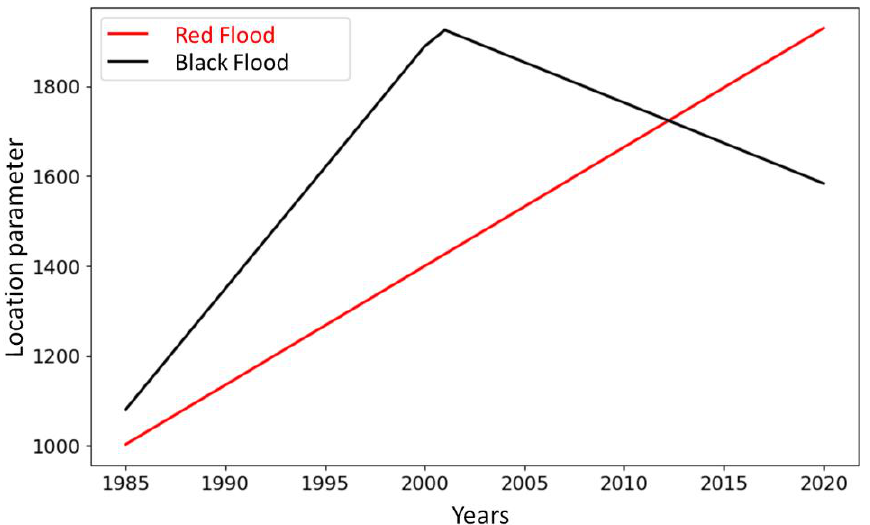
Figure A1. Evolution over time of the GEV location parameter giving the best fitting results to the AMAX series of the red and black floods. Table A1. Results of the regression of AMIN (h) with Time and Rainfall over the Niger river Basin